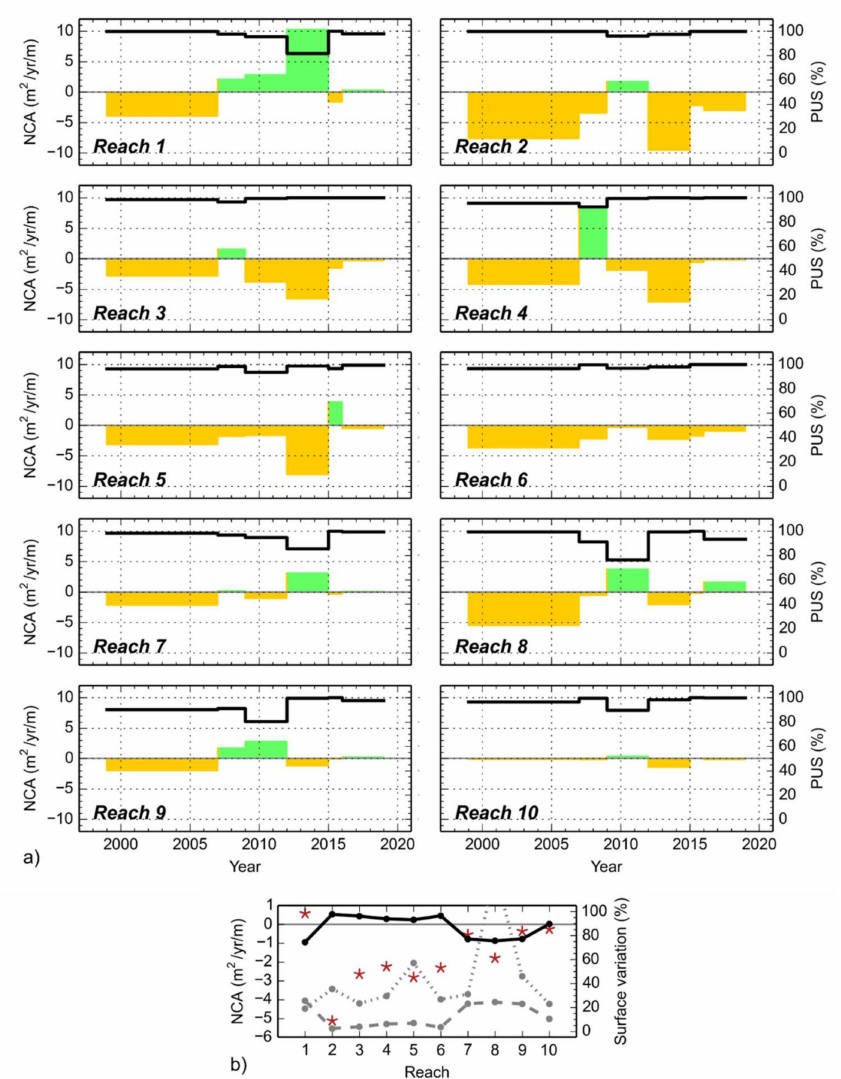
Figure 6. ( a ) Net channel activity (NCA) and percentage of channel unchanged area (PUS) for each consecutive time step. The green (yellow) highlights, keyed to the left y -axis, represent prevailing changes from active channel (floodplain) to floodplain (active channel). The black line is keyed to the right y -axis and represents the percentage of unchanged active-channel surface referring to the oldest riverbed of each time step; ( b ) NCA (red asterisks), PUS (black line), percentage of channel area converted into floodplain (PDS) (dashed grey line) and percentage of newly-formed channel area (PES) (dotted grey line) referred to the 1999 active channel, derived from the comparison between the 1999 and the 2019 active channels at reach scale. The outlier measured in reach 8 is